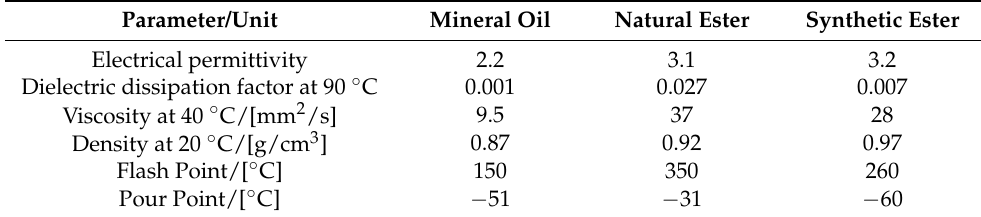
Table 1. Fundamental parameters of the liquid tested. Parameter/Unit Mineral Oil Natural Ester Synthetic Ester Electrical permittivity 2.2 3.1 3.2 Dielectric dissipation factor at 90 ◦ C 0.001 0.027 0.007 Viscosity at 40 ◦ C/[mm 2 /s] 9.5 37 28 Density at 20 ◦ C/[g/cm 3 ] 0.87 0.92 0.97 Flash Point/[ ◦ C] 150 350 260 Pour Point/[ ◦ C] − 51 −